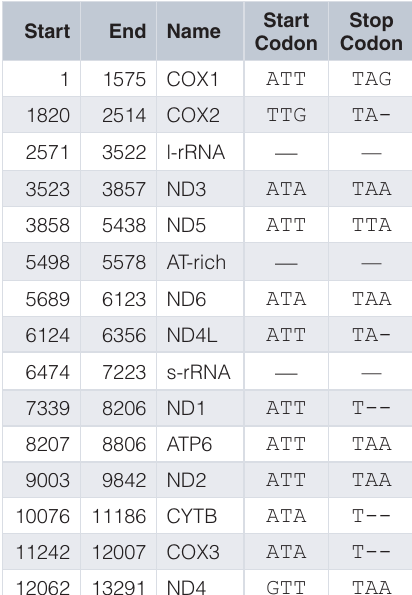
Table 2. mtDNA tRNA sites. Predicted tRNA sites in the Nippostrongylus brasiliensis mitochondrial genome. One truncated tRNA site between the ND4 and COX1 genes (detected by cmscan ) could not be fully annotated.